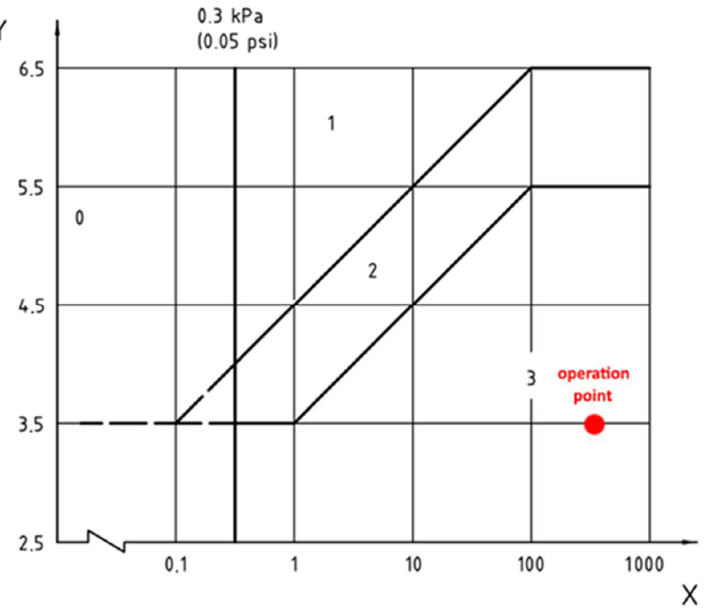
Figure 11. Aggressiveness of the environment, according to [5], (X—partial pressure of H 2 S, Y—pH of the environment).